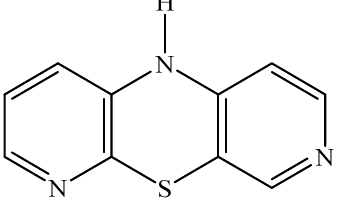
Figure 1. Structural formula of 10 H -3,6-diazaphenothiazine (DAPT).